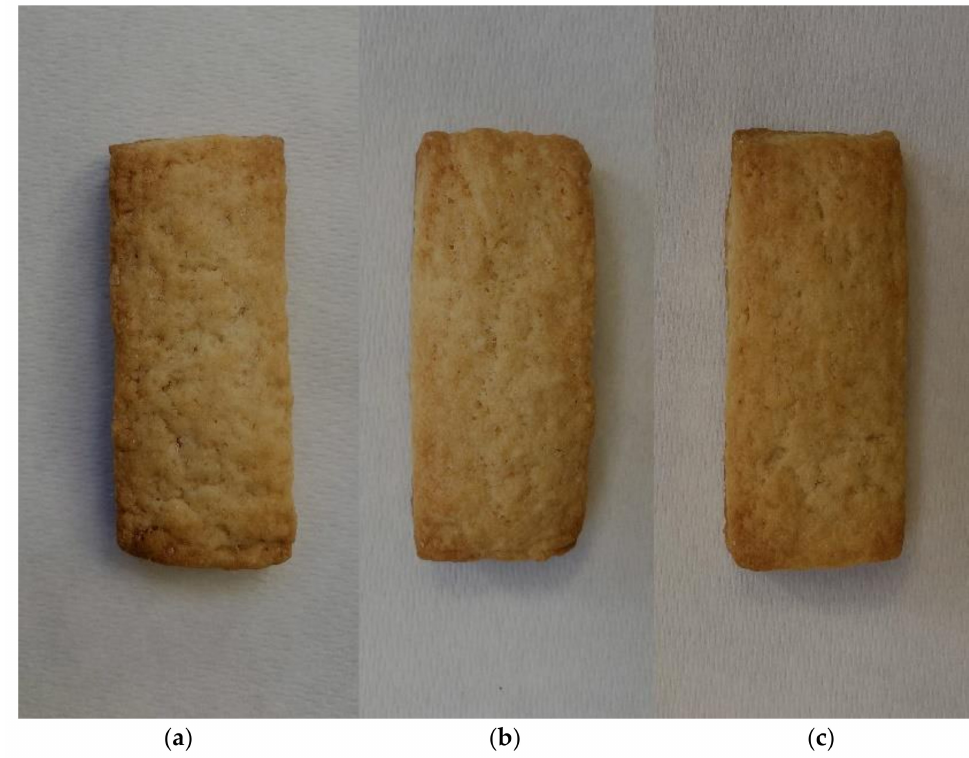
Figure 1. ( a ) Biscuits prepared with 100% sunflower oil; ( b ) biscuits prepared with sunflower oil (50%) and durum wheat oil (50%); ( c ) biscuits prepared with 100% durum wheat